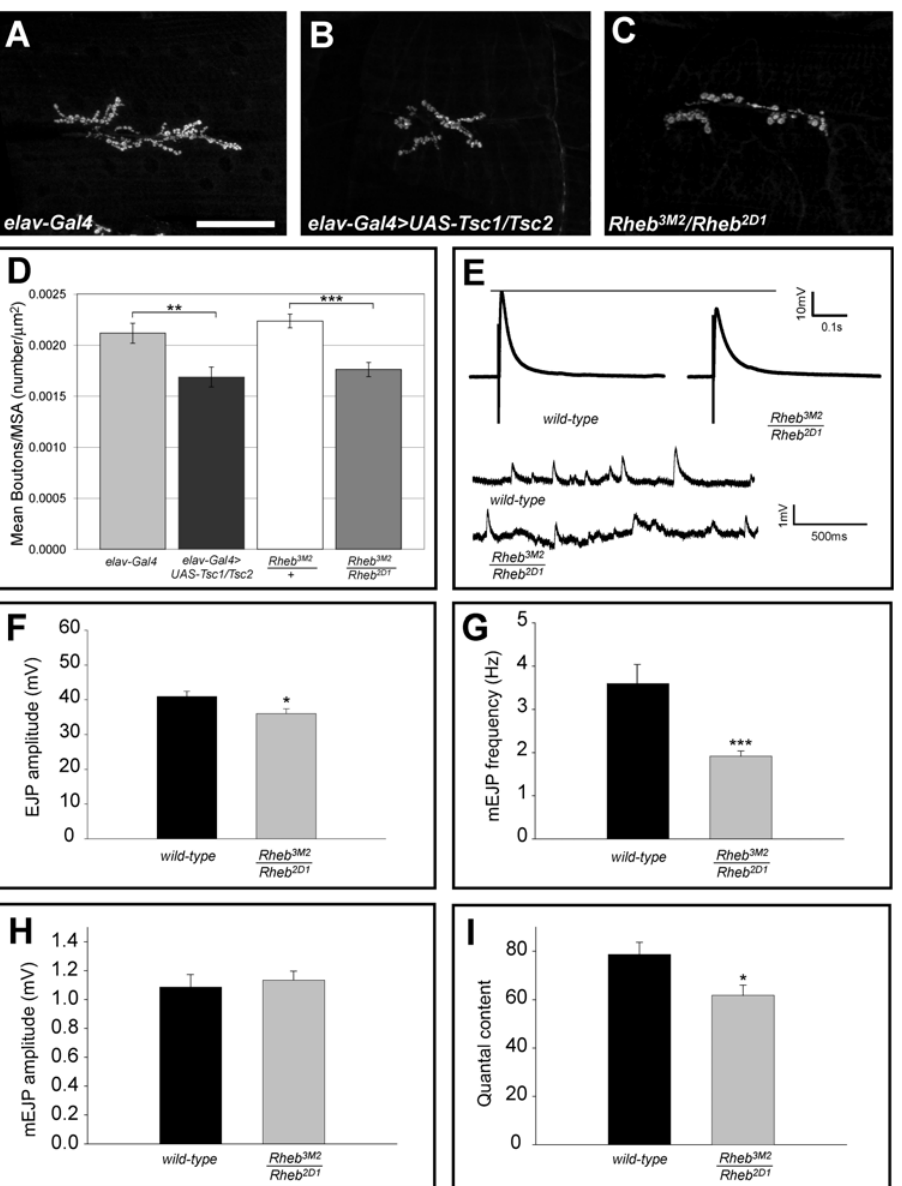
Figure 2. Rhebactivity is required for normal synapse assembly. Panels A–C show anti-CSP staining of larval NMJs in a control animal (A, elav-Gal4 driver alone), an animal bearing elav-Gal4 . UAS-Tsc1, UAS-Tsc2 (B), or a Rheb partial loss of function mutant (C). Reduction of Rheb function produced by either neuron-directed expression of Tsc1 and Tsc2 (n=22) or mutation of Rheb (n=40) significantly reduced synapse size compared to controls with elav-Gal4 alone (n=44) or animals heterozygous for a Rheb mutation (n=17), as measured by the number of synaptic boutons/muscle area (D). Panel E shows sample EJP traces for wild-type and Rheb mutant NMJs, as well as baseline recordings from these preparations showing the size and frequency of mini-EJPs. Panels F, G, and I show reductions in EJP amplitude, mini-EJP frequency, and quantal content for Rheb mutant synapses (n=29) compared to wild-type controls (n=10). Mini-EJP amplitude did not show a significant change (H). The scale bar in A is 50 microns.